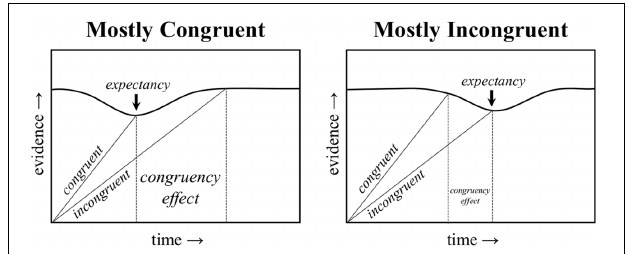
FIGURE 1 | A representation of how expectancy-driven reductions in the response threshold can produce a proportion congruent effect. An earlier drop in the threshold in the mostly congruent condition benefits congruent trials, whereas a later drop in the threshold in the mostly incongruent condition benefits incongruent